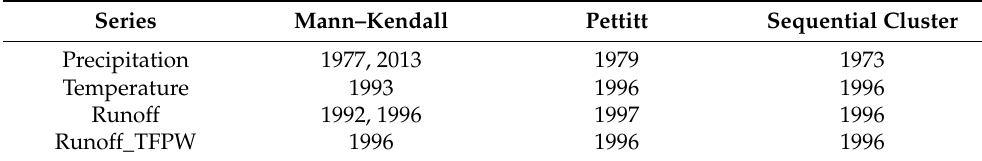
Table 2. Mutation test results of annual precipitation, temperature, and runoff during 1973–2014.